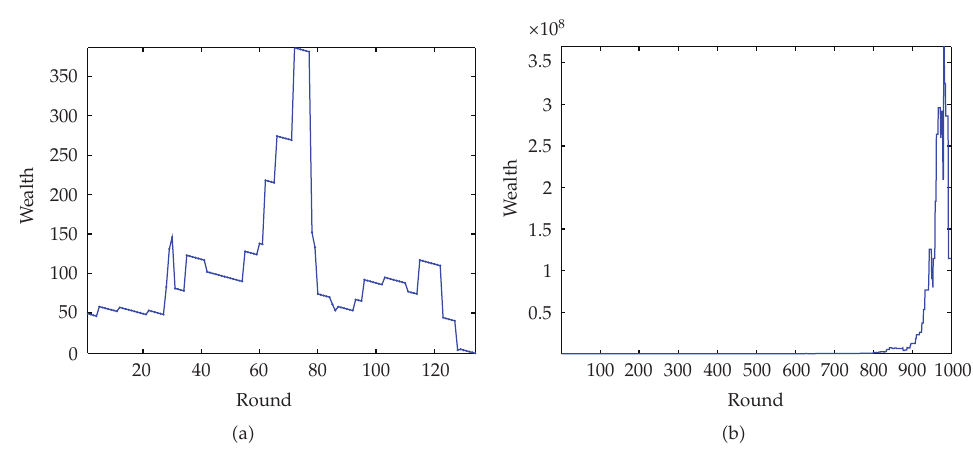
Figure 2: A sequence of rounds of Betweenies (cid:3) party version (cid:4) leading to ruin (cid:3) a (cid:4) and a large wealth (cid:3) b (cid:4) , with a starting wealth of w (cid:7) 50. Note the large lost bet in the final rounds of (cid:3) b (cid:4)